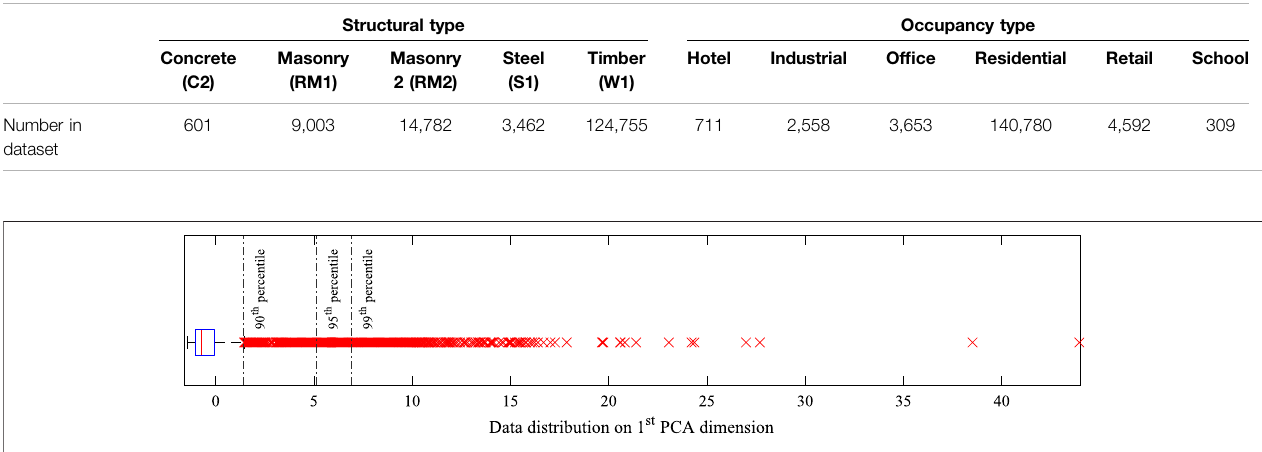
FIGURE 2 | Distribution of the building variables on the fi rst PCA dimension. The box plot indicates that a limited number of datapoints are located far from the majority of datapoints accumulated near the median values.